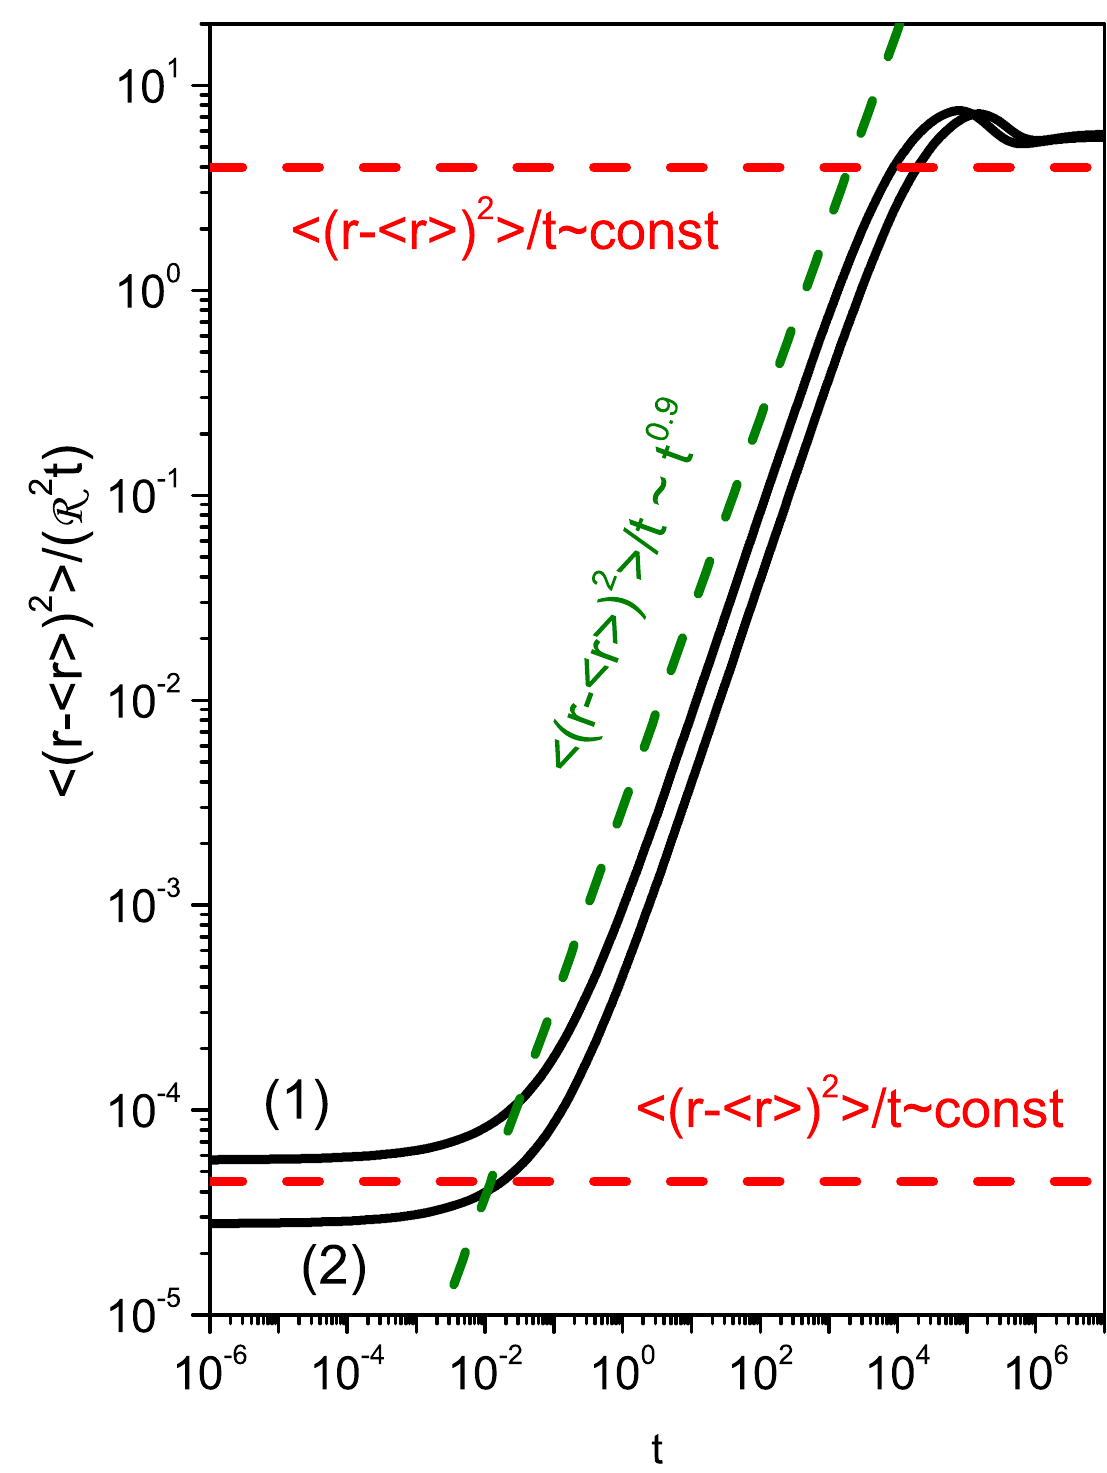
Fig 5. Behavior of the mean square displacement. The time dependent behavior of the mean square displacement for the situations analyzed in Fig (4) is shown. We observe that the diffusion is usual for short and long times in both cases. For intermediate times, the diffusive regime is different from the usual one, with superdiffusive characteristics. These regimes are evidenced by the red and green dashed lines. In this figure, we used K (cid:5) 10 (cid:3) 10 m 2 s (cid:3) 1 , R 1 (cid:5) 9 (cid:6) 10 (cid:3) 6 m , R 2 (cid:5) 9 : 3 (cid:6) 10 (cid:3) 6 m , and p ( γ ) = δ ( γ −